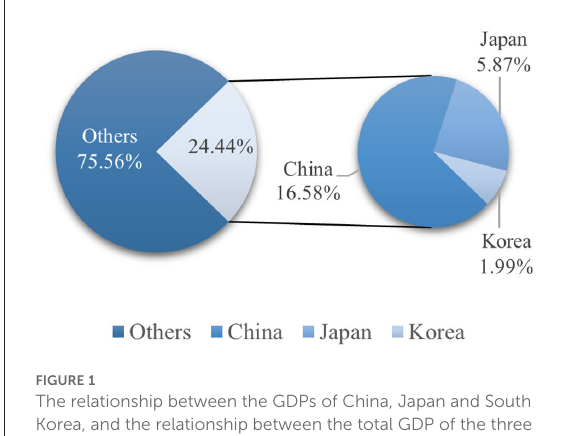
FIGURE1 The relationship between the GDPs of China, Japan and South Korea, and the relationship between the total GDP of the three countries and total world GDP. The unit in the figure is 100 million U.S.